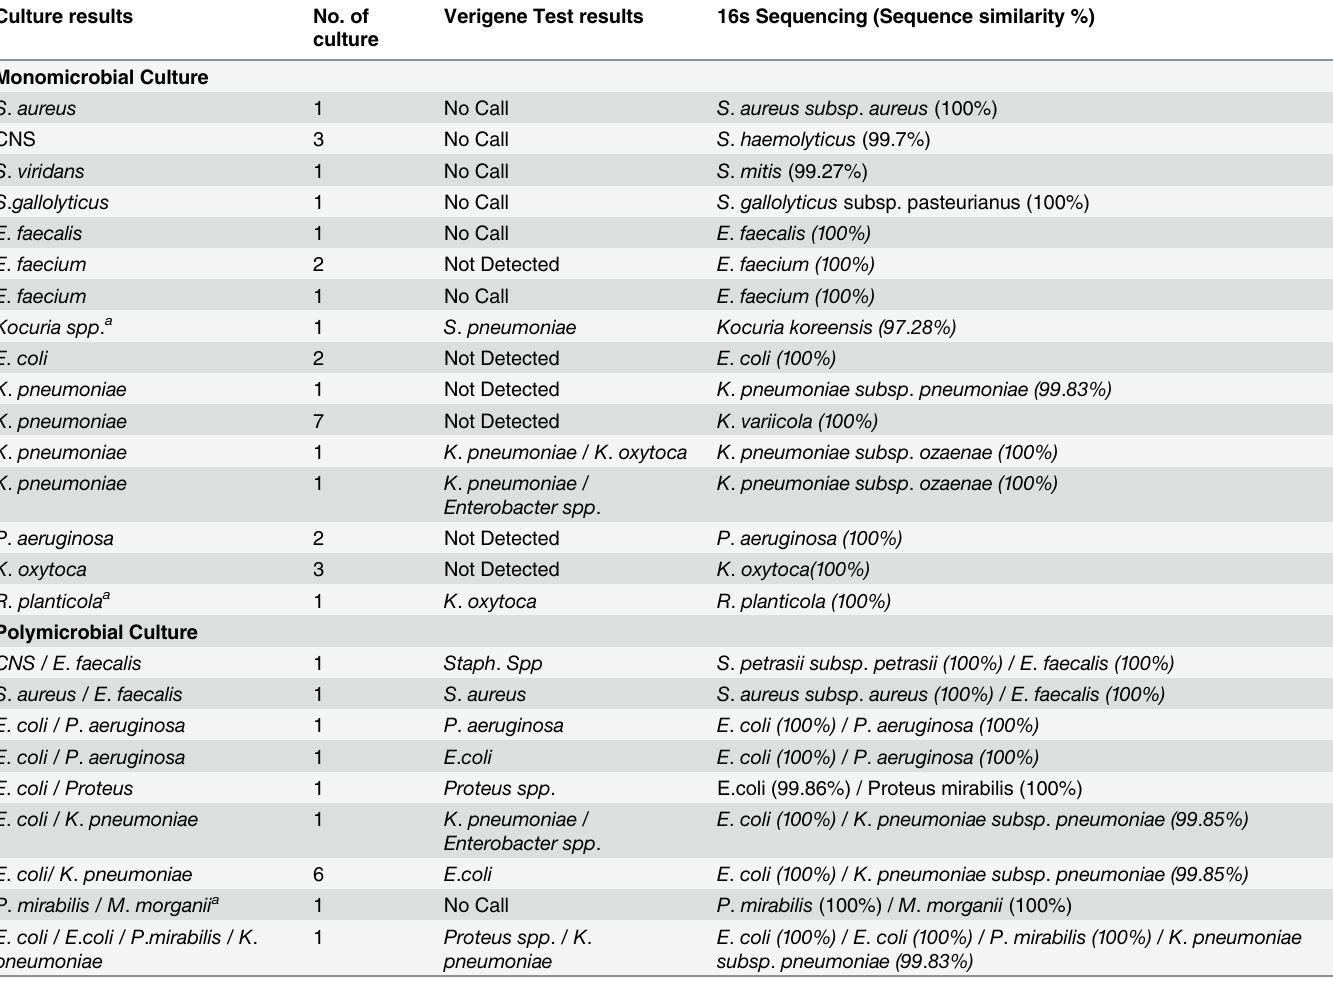
Table 3. The identities of bacteria in cultures with discordant results reported by culture-based method and the Verigene Test. Culture results